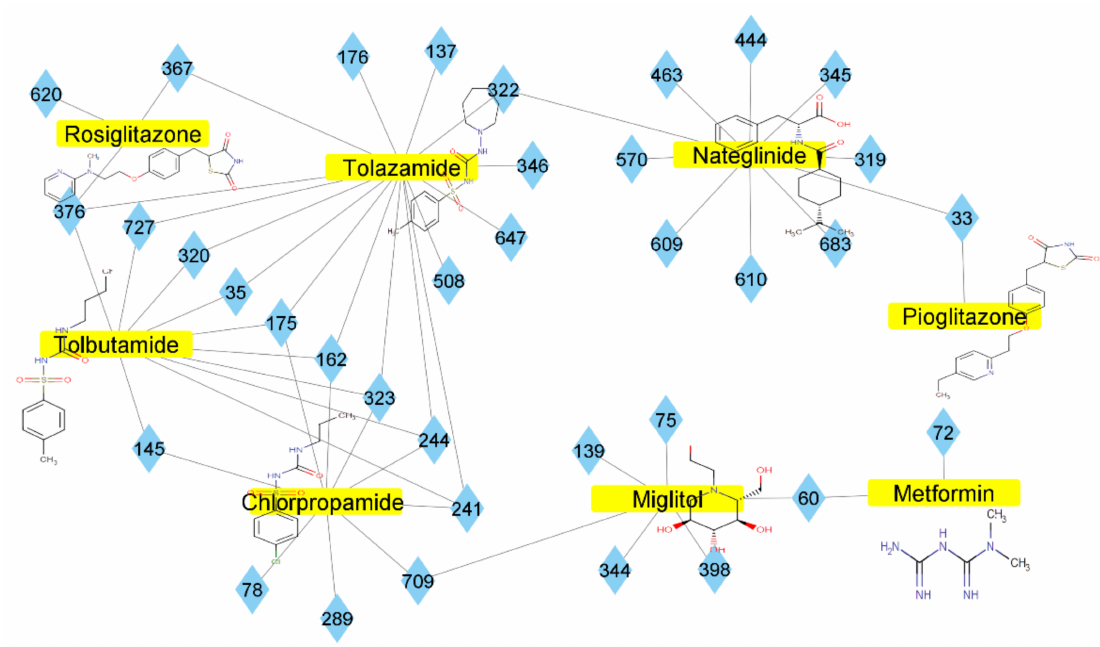
Figure 2. Molecular similarity analysis of potential anti-T2DM Asian propolis compounds to FDA- approved antidiabetic drugs. The similarity was performed on the extended connectivity fingerprint 4 (ECFP4) molecular fingerprints of compounds with a Tanimoto similarity cut-off score of 80%. Blue diamond shape denotes the number code of potential compounds that correspond to the compounds in Table